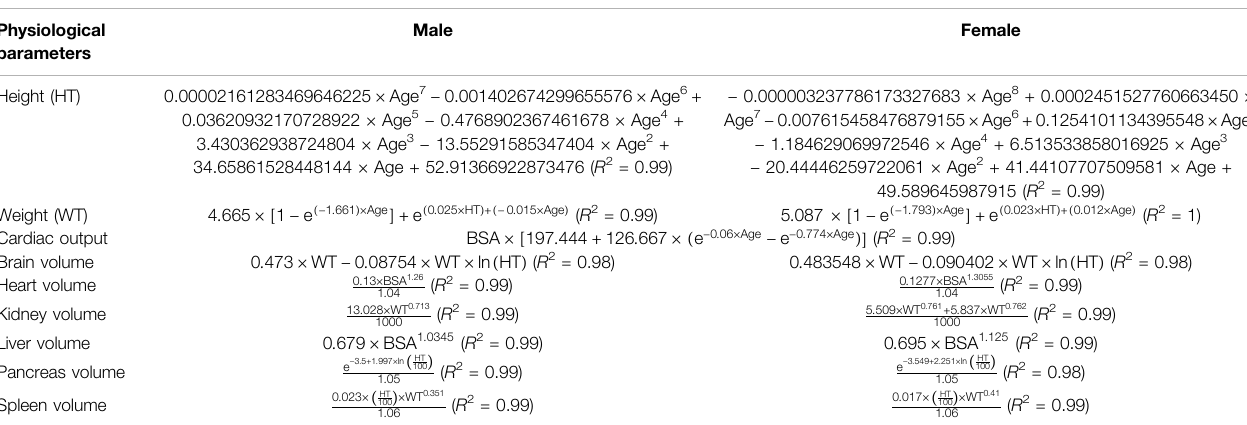
TABLE 2 | Physiological parameter equations of Chinese pediatric